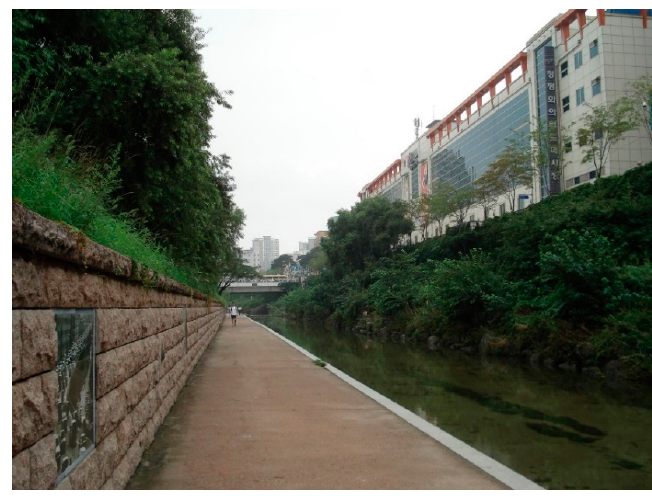
Figure 11. Historical image embedded in wall on the left; market building on the right looming over the Cheonggyecheon.